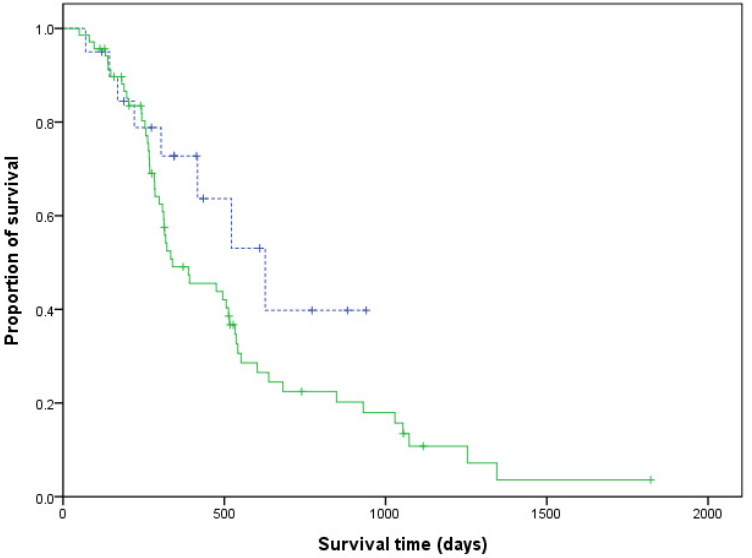
Figure 2. Kaplan–Meier curves of the survival time for dogs with lymphoma. Dogs that received the